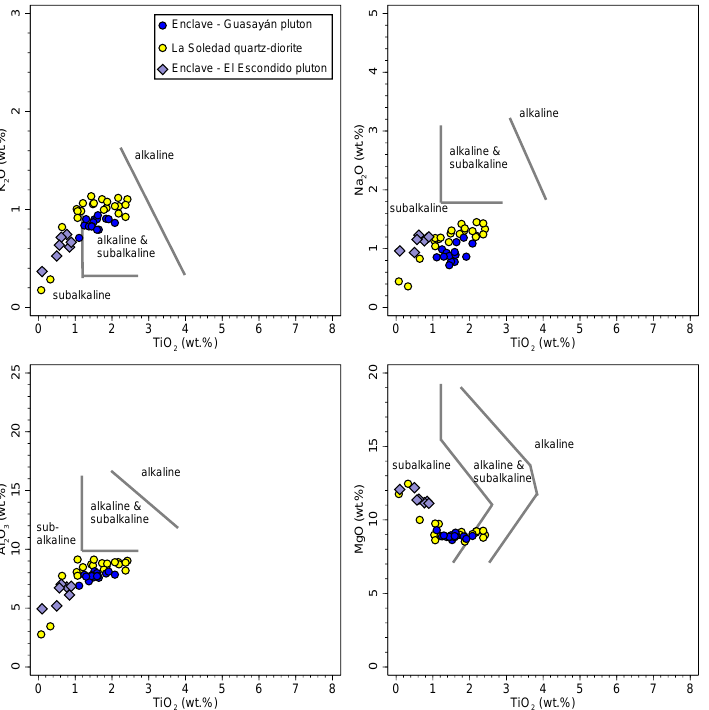
Figure 8. Composition of amphiboles from the granitoids of the Sierra de Guasayán. MgO vs. TiO 2 , Na 2 O vs. TiO 2 , K 2 O vs. TiO 2 and Al 2 O 3 vs. TiO 2 diagrams. Alkaline to subalkaline fields after [14]. Fe/(Fe + Mg) ratios of biotite (0.46–0.66) and amphibole (0.43–0.57) from the studied granitoids indicate that these rocks crystallized under oxidizing conditions (Figure 7A,B) with oxygen fugacity conditions between QFM + 1 and QFM + 2 (Figure 7B), showing Fe/(Fe + Mg) ratios typical of rocks of the magnetite series (Figure 7B; [27]). This is coherent with the presence of magnetite in most of the samples. Interestingly, the lower Fe/(Fe + Mg) ratios of amphibole and biotite from the mafic enclave of the El Escondido pluton (Figure 7) suggest it crystallized under the most oxidizing conditions, which could also be related to the subsolidus alteration experienced by the